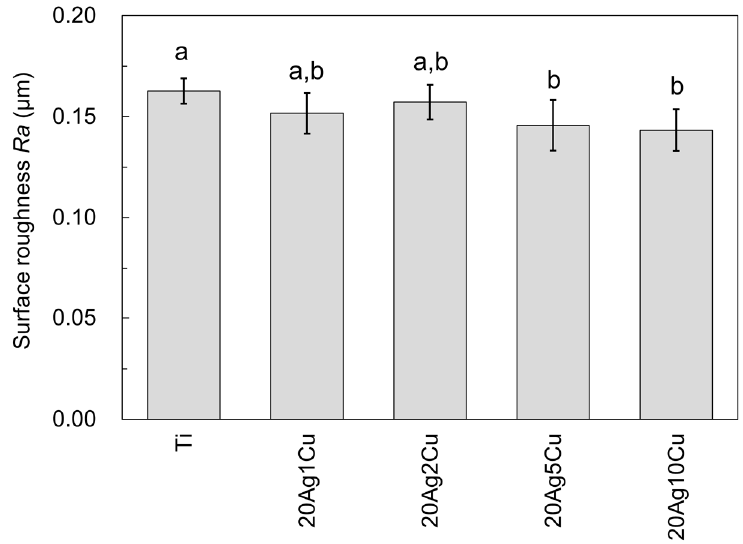
Figure 8. Surface roughness ( Ra ) of the Ti-Ag-Cu alloys. Identical letters indicate a statistically insignificant difference ( p > 0.05).